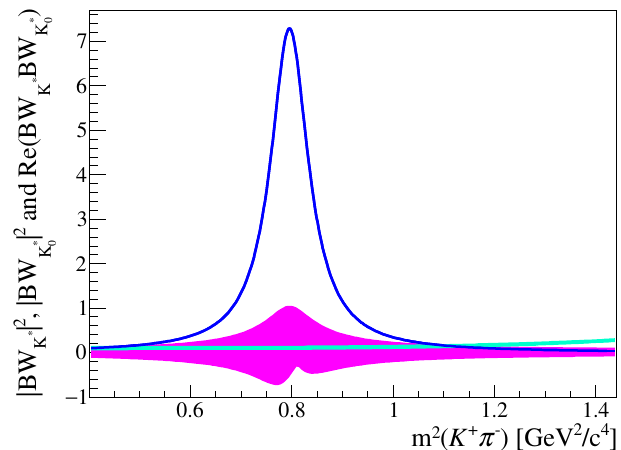
( m 2 ) j 2 and (magenta) the interference term K(cid:25) 0